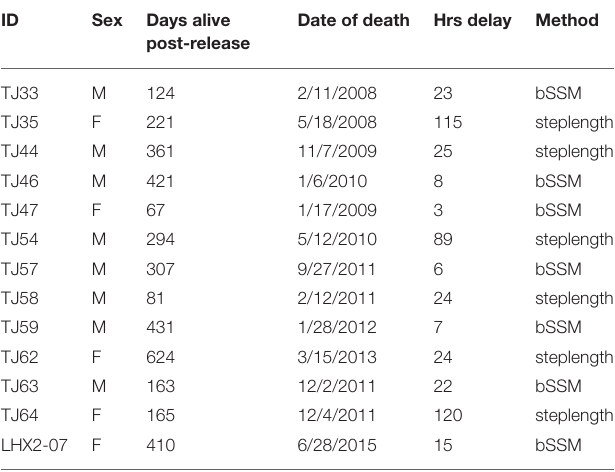
TABLE 1 | Descriptions of predation events detected via Life History (LHX) tags for each juvenile Steller sea